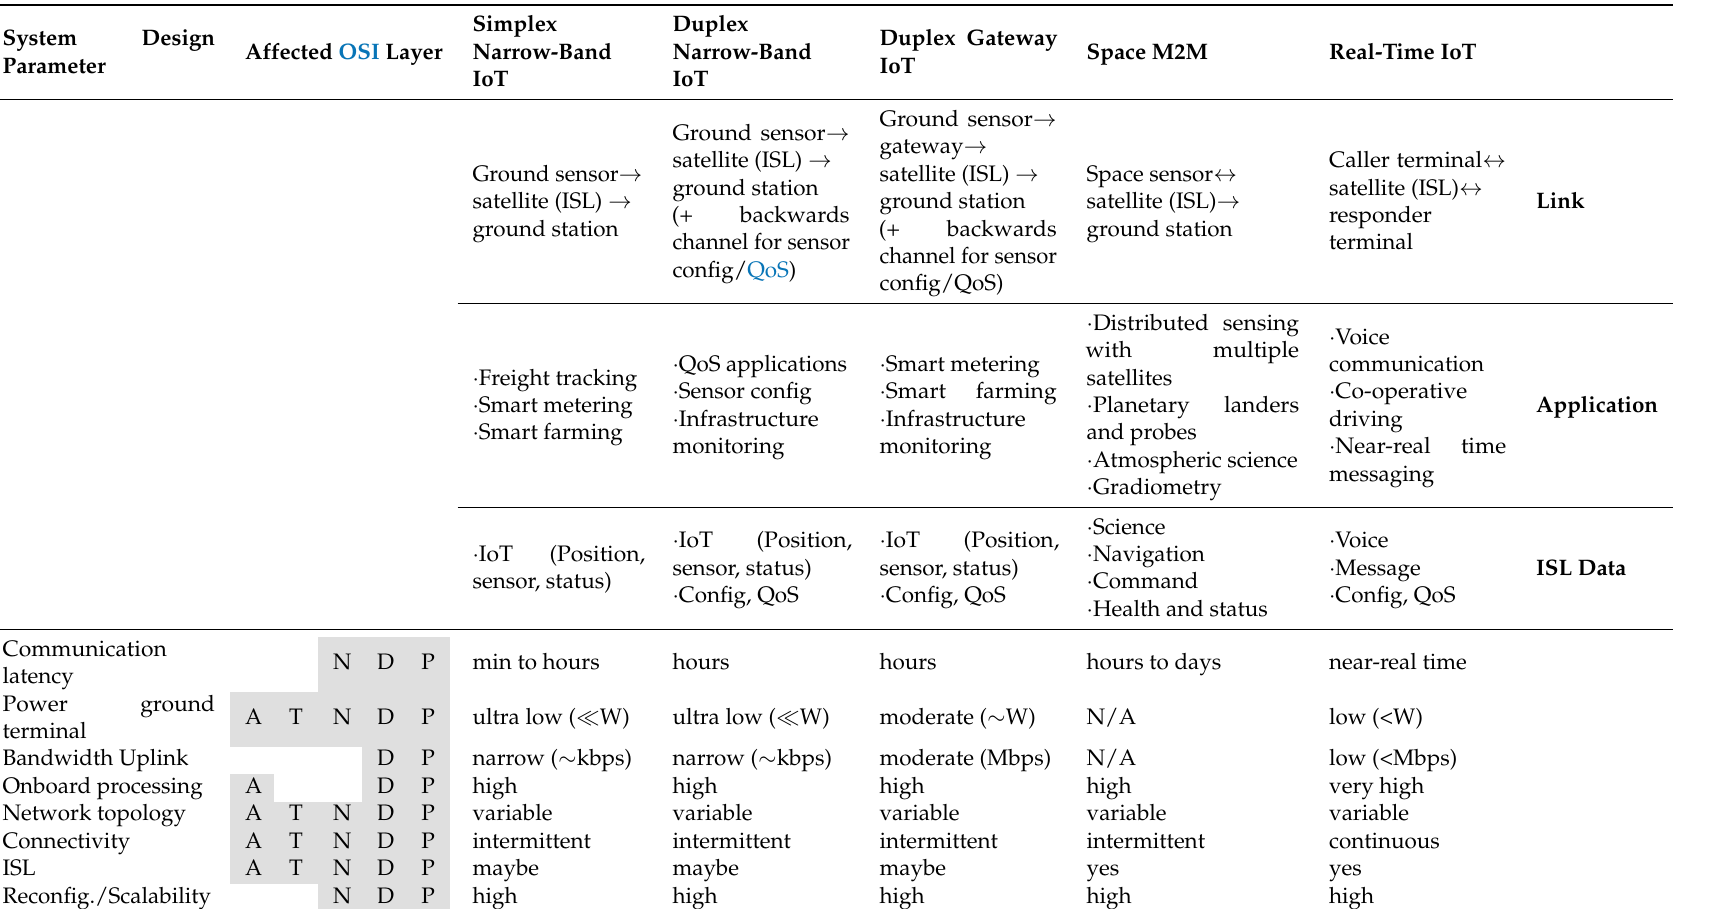
Table 4. System design parameters for IoT/M2M applications and the affected OSI layers of an ISL link. A: Application, T: Transport, N: Network, D: Data Link, and P: Physical